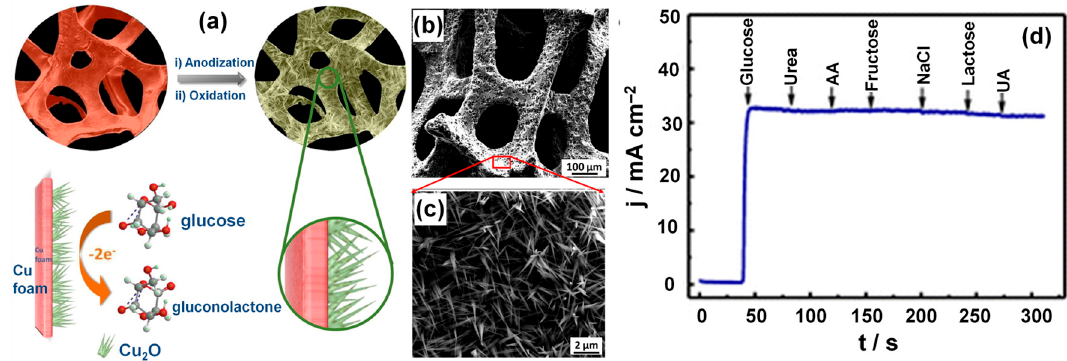
Figure 3. ( a ) Schematic illustration showing the fabrication of the 3D Cu foam–supported mesoporous Cu 2 O nanothorn array electrode and its function in the electrocatalytic oxidation of glucose; ( b ) Typical low- and ( c ) high-magnification SEM images of the Cu foam–supported Cu 2 O nanothorn array electrode; ( d ) Amperometric response of the Cu foam–supported Cu 2 O nanothorn array electrode toward the addition of 1 mM glucose and various 0.02 mM interfering species in the 0.1 M NaOH solution at 0.55 V vs. Ag|AgCl|KCl sat . Reprinted and adapted with permission from Reference